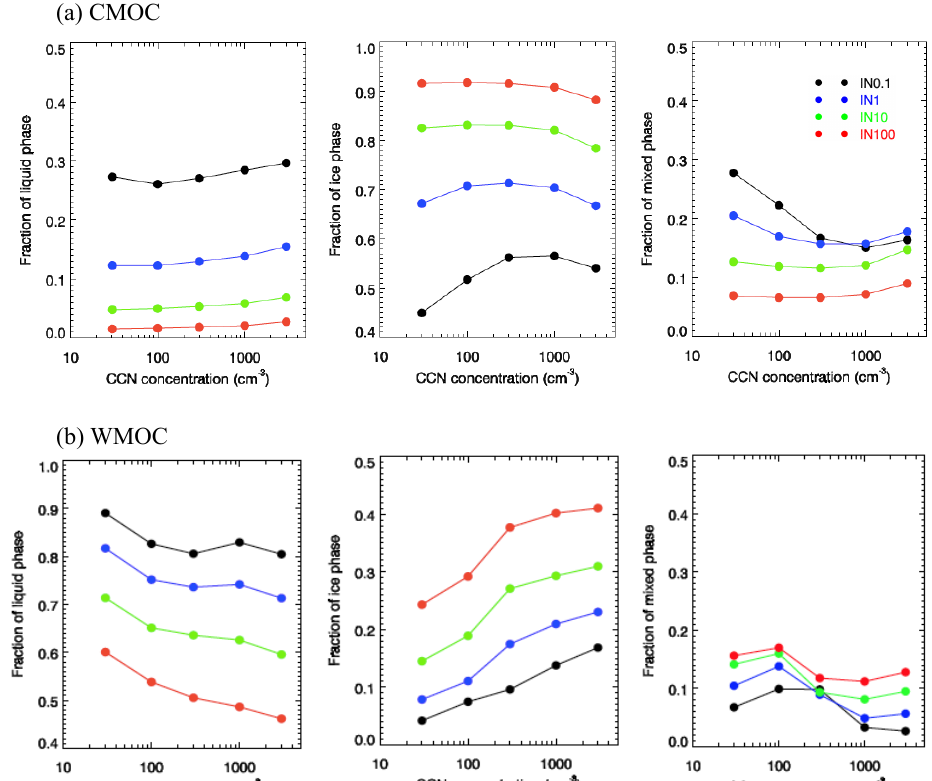
Figure 13. The fraction of the liquid phase (left), ice phase (middle), and mixed phase (right) for the (a) the CMOC and (b) the WMOC over the simulation period by excluding the first 2h. The cloud phase for each cloud grid point that has a total condensate mass of larger than 1 × 10 − 5 kgkg − 1 is identified based on the ratio of liquid to ice water mixing ratios. If the ratio is larger than 0.99 or smaller than 0.01, the grid point is identified as liquid phase or ice phase, respectively. Between these values is identified as mixed phase. The fraction for each cloud phase is calculated by the number of grid points identified for the phase divided by the total number of the grid points of all three phases. Thus, the fractions of all three add up to 1 for each simulation